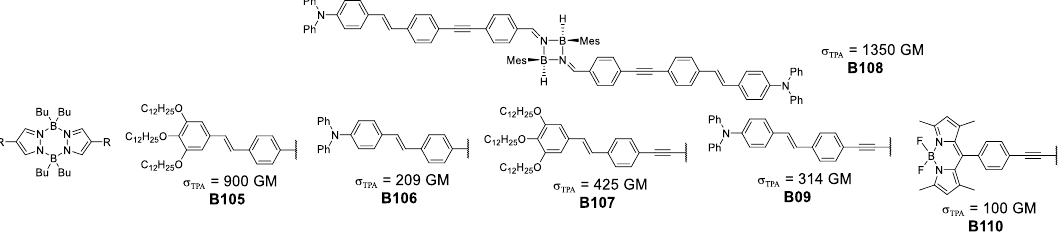
Figure 34. Scheme for obtaining a TPA-responsive boronate of major structural accessibility and σ TPA value.